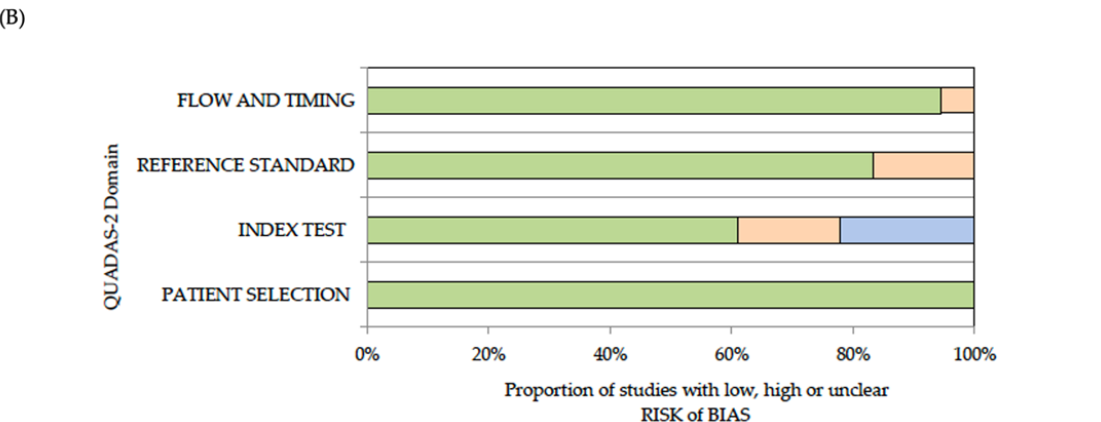
Figure 2. Analysis of bias risks (low, unclear, high) of analysed studies according to each bias. domain ( A ), and proportion of studies according to each domain ( B ) [15 – 17,21 – 36].